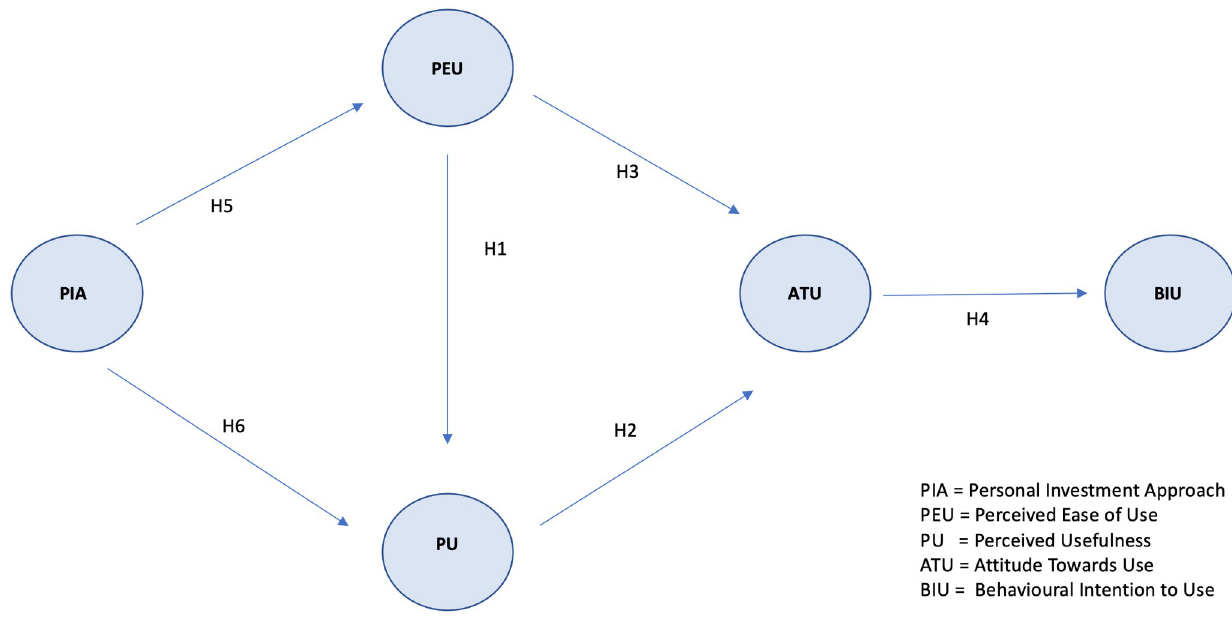
Fig 1. The technology acceptance